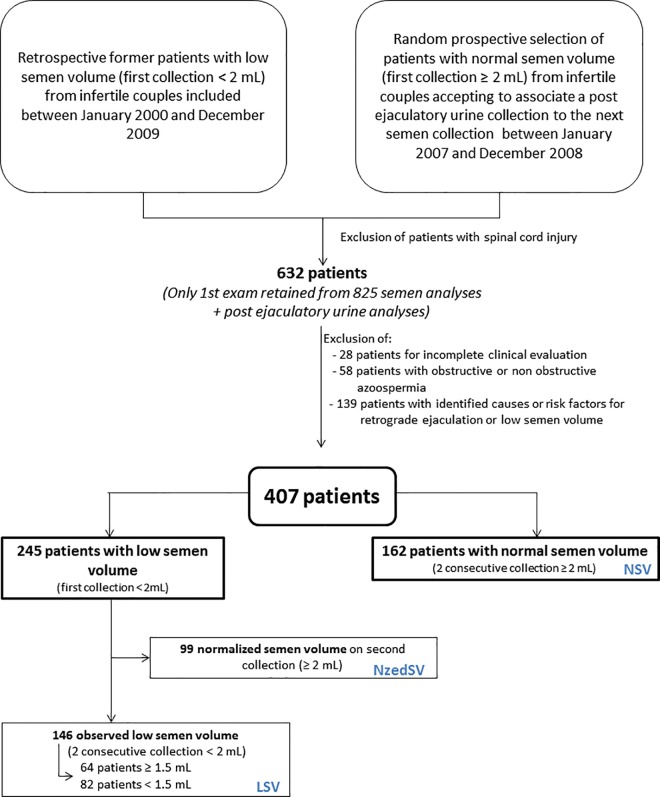
Flowchart and design of the study.